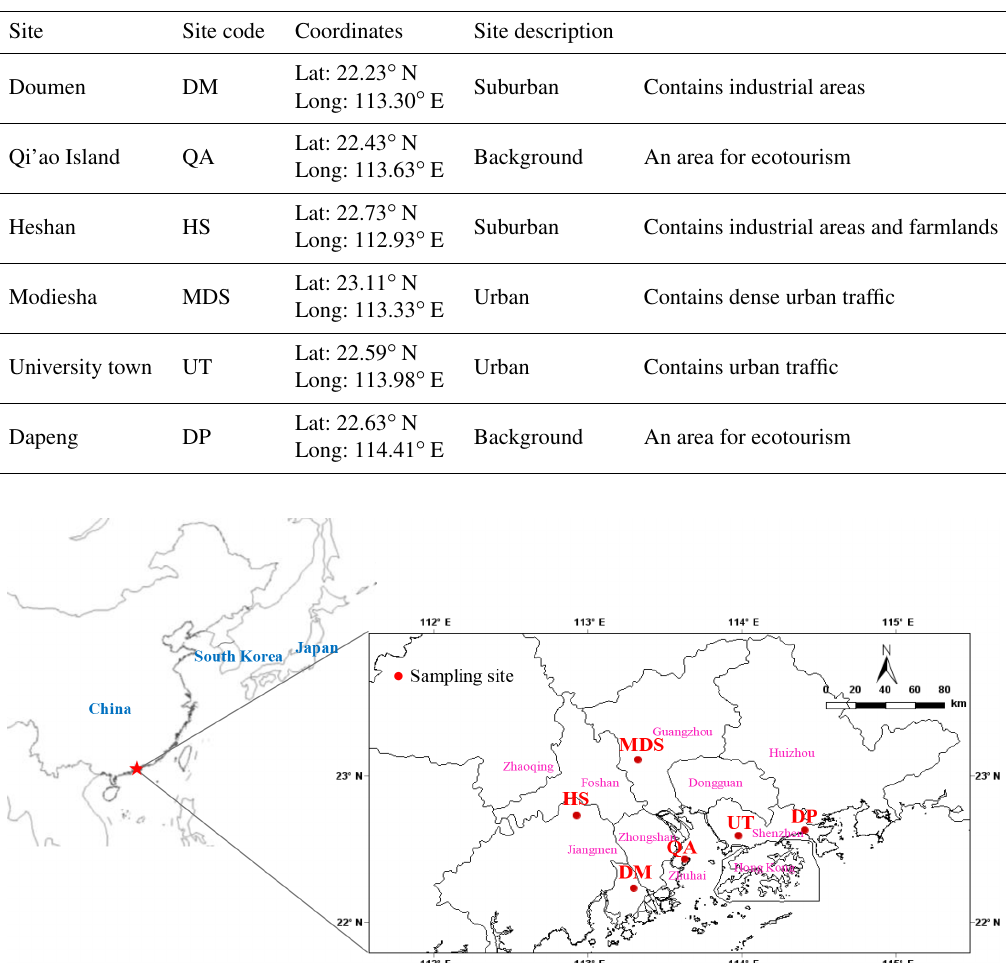
Table 1. Description of the sampling sites in the PRD.